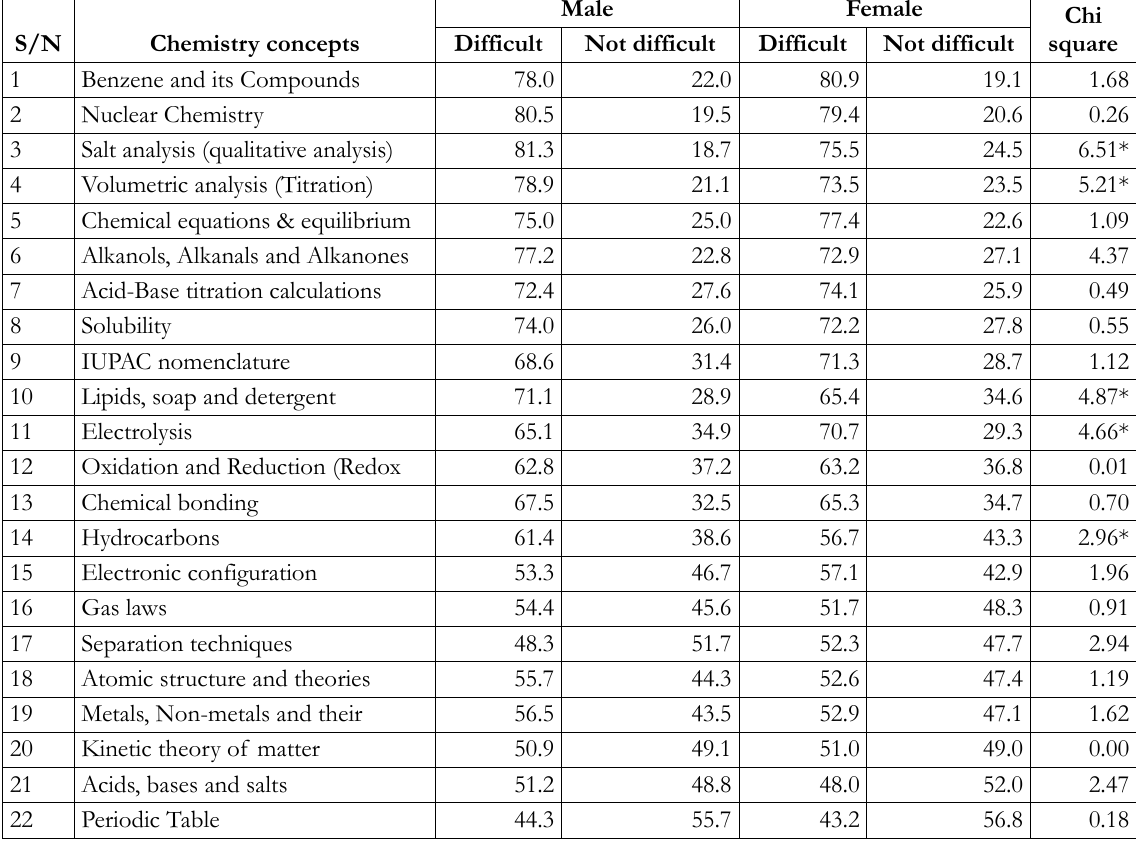
Table 2. Crosstabulation of perception of the difficulty of chemistry concepts by male and female students The results confirmed that of the 22 topics, only five showed gender differences. These are salt analysis (qualitative analysis), volumetric analysis (titration); lipids, soap and detergent; electrolysis; and hydrocarbons. While benzene and its compounds remain the most difficult concepts for the female students (80.9%), salt analysis is perceived as most difficult by the male students (81.3%). The second component of the first research question probed possible urban/rural differences. The results of the chi-square test are shown in Table